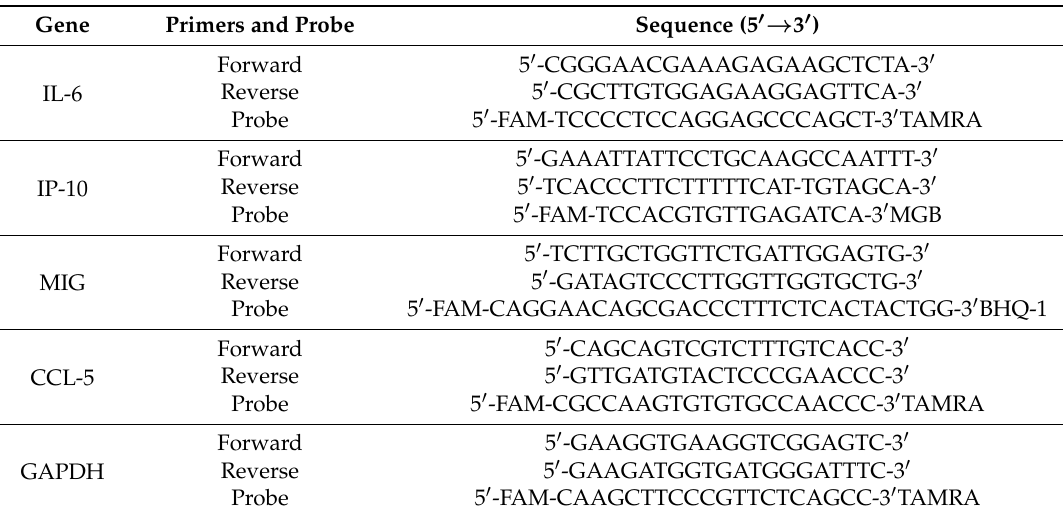
Table 2. Primers and probes used in this